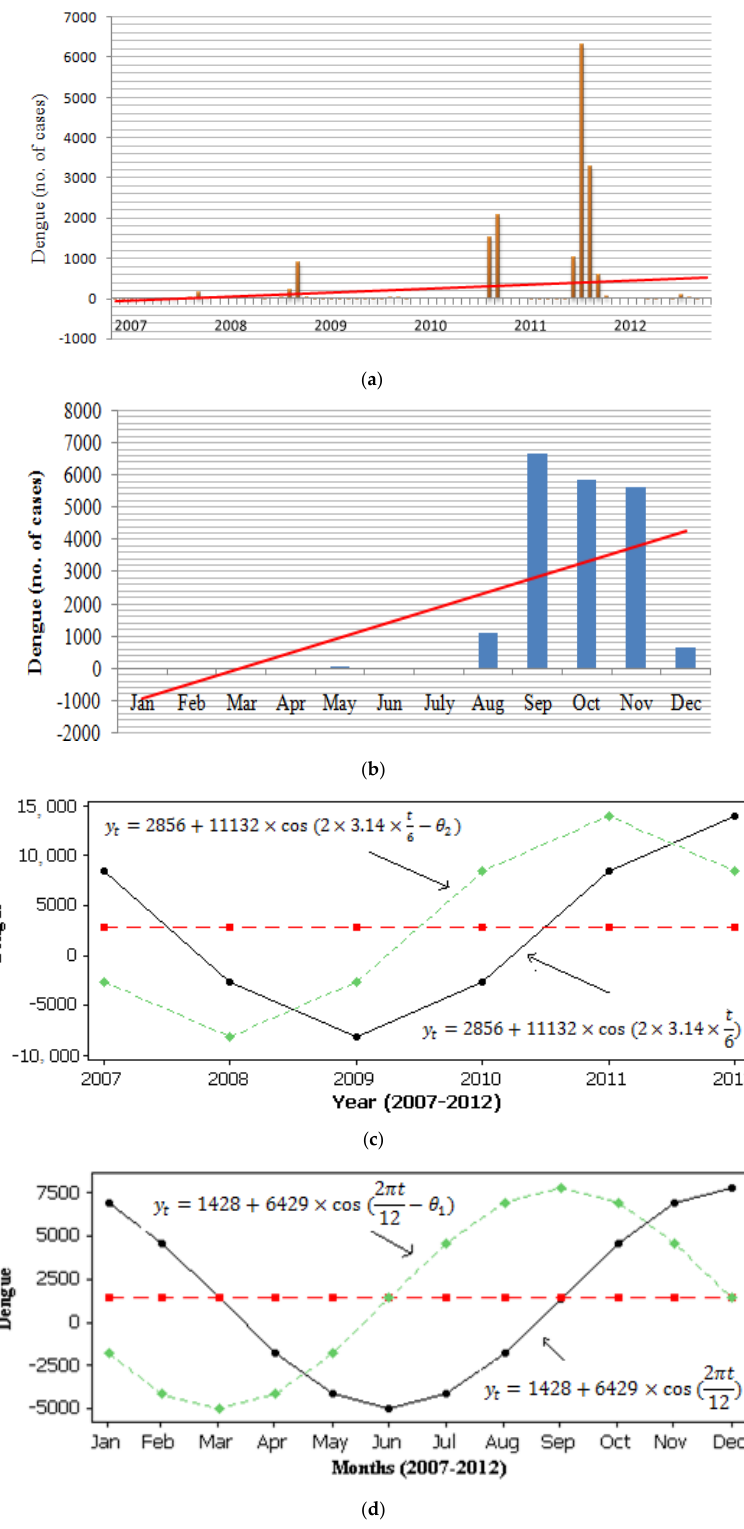
Figure 8. ( a ) Monthly time series of the number of reported dengue cases in Lahore City, 2007–2012. ( b ) Seasonal time series of the number of reported dengue cases in Lahore City, 2007–2012. ( c ) Transformation of cosine functions to represent an annual cycle of yearly dengue incidence for Lahore, Pakistan, for the years 2007–2012. ( d ) Transformation of cosine functions to represent an